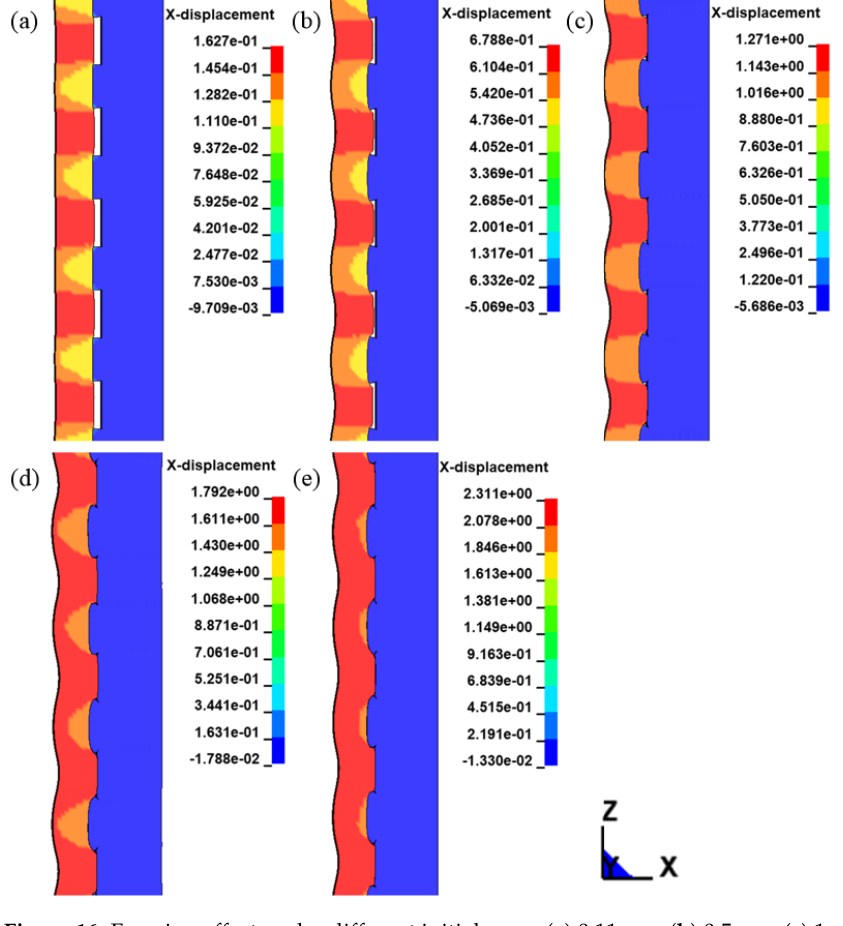
Figure 16. Forming effect under different initial gaps. ( a ) 0.11 mm ( b ) 0.5 mm ( c ) 1 mm ( d ) 1.5 mm ( e ) 2 mm.